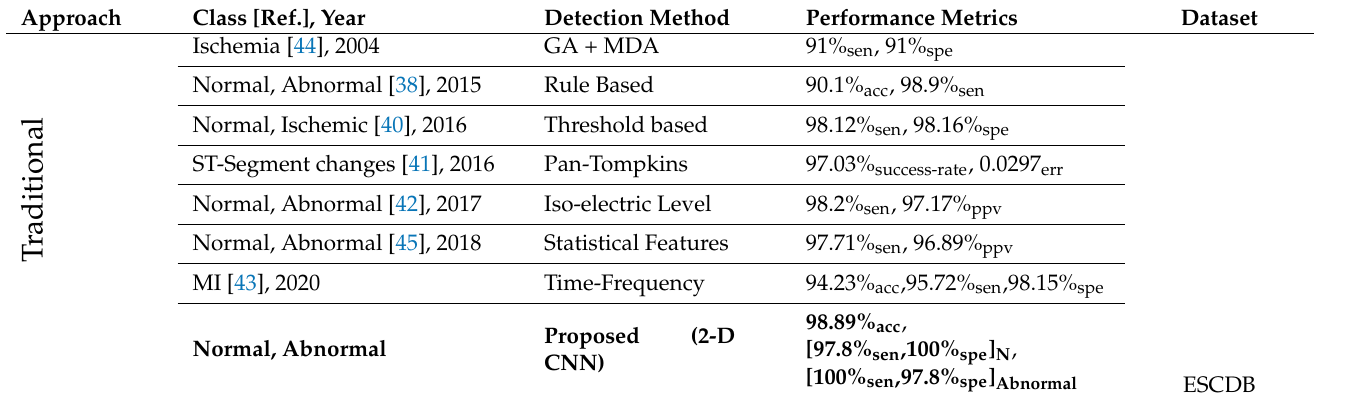
Table 4. Comparison of traditional and machine learning approaches for ECG